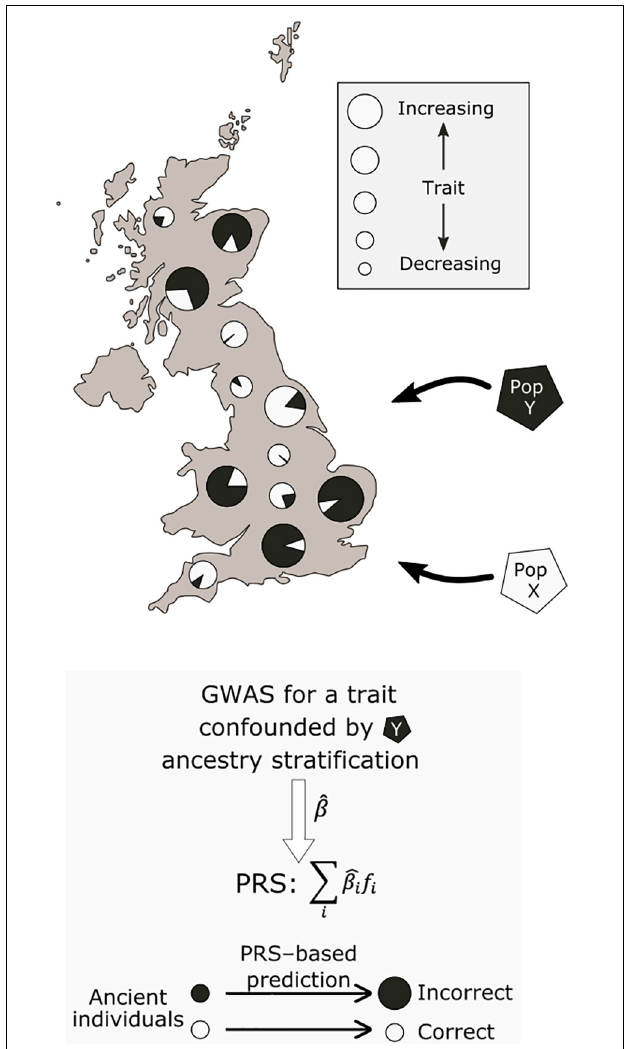
FIGURE 2 | Potential effect of population stratification in GWAS. Two ancestral populations, X and Y, have contributed differing ancestry proportions to present-day individuals. Due to non-genetic environmental effects, individuals with a larger proportion of population Y ancestry have higher values for a measured trait. This may lead to biased GWAS effect size estimates, which associate population Y ancestry with increasing values of the trait. When used to make inferences about the past, this would lead to systematically inflated polygenic scores for this trait in samples from population